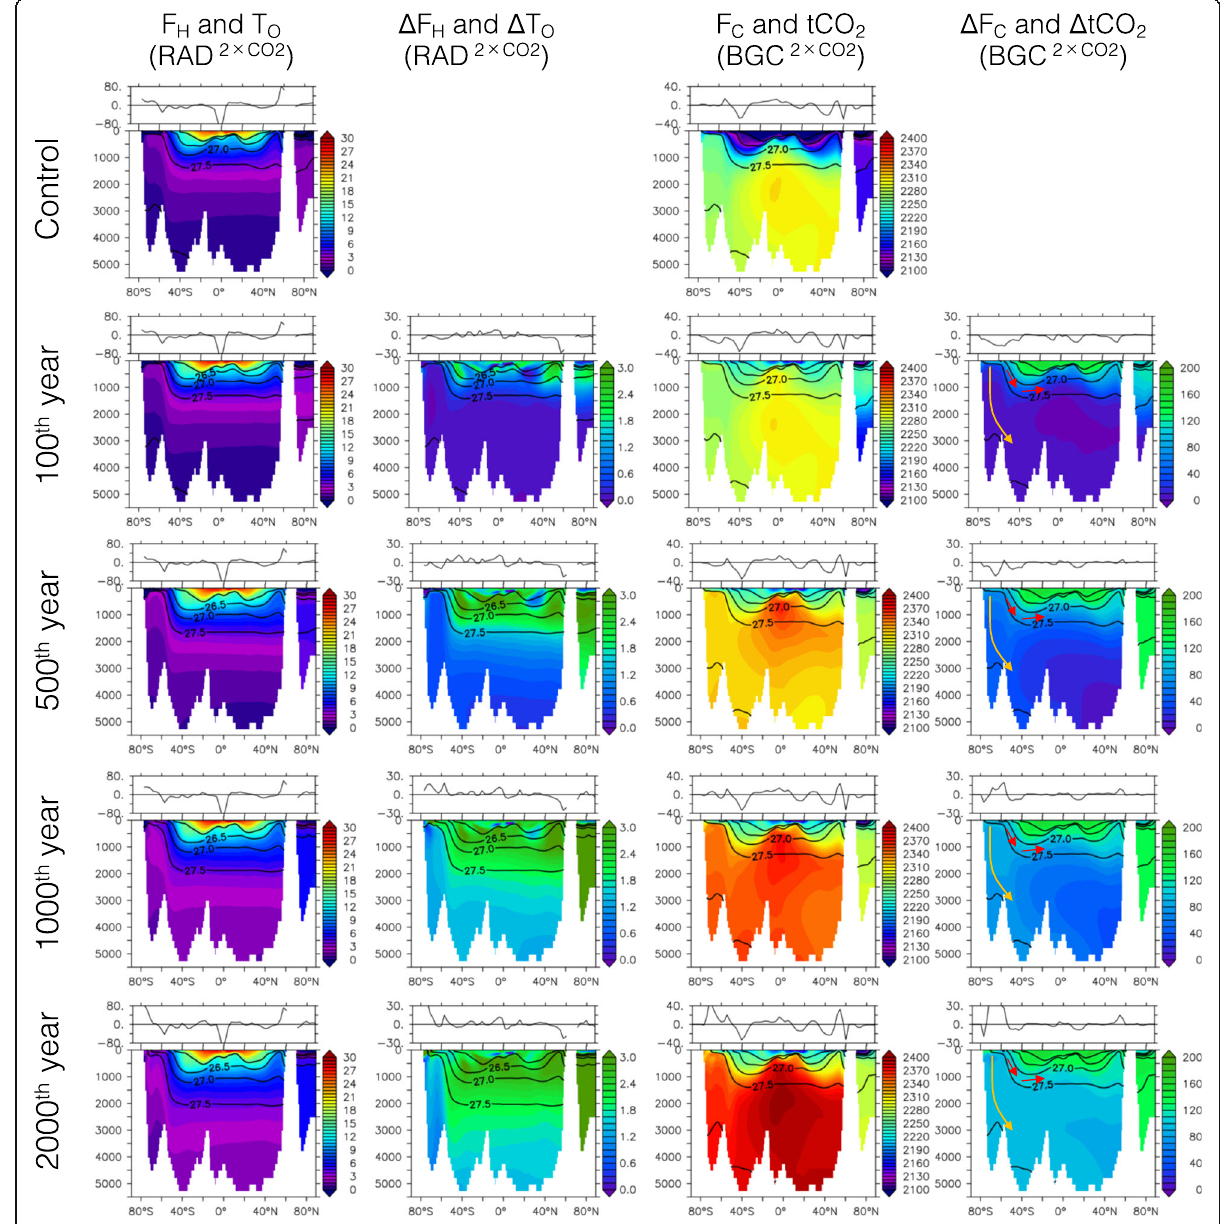
Fig. 8 Atmosphere-ocean heat and carbon dioxide (CO 2 ) fluxes (plots) and vertical distributions of ocean temperature and dissolved inorganic carbon (T O and tCO 2 ; shades) in the Pacific Ocean (150°W). See Fig. 7 legend for further